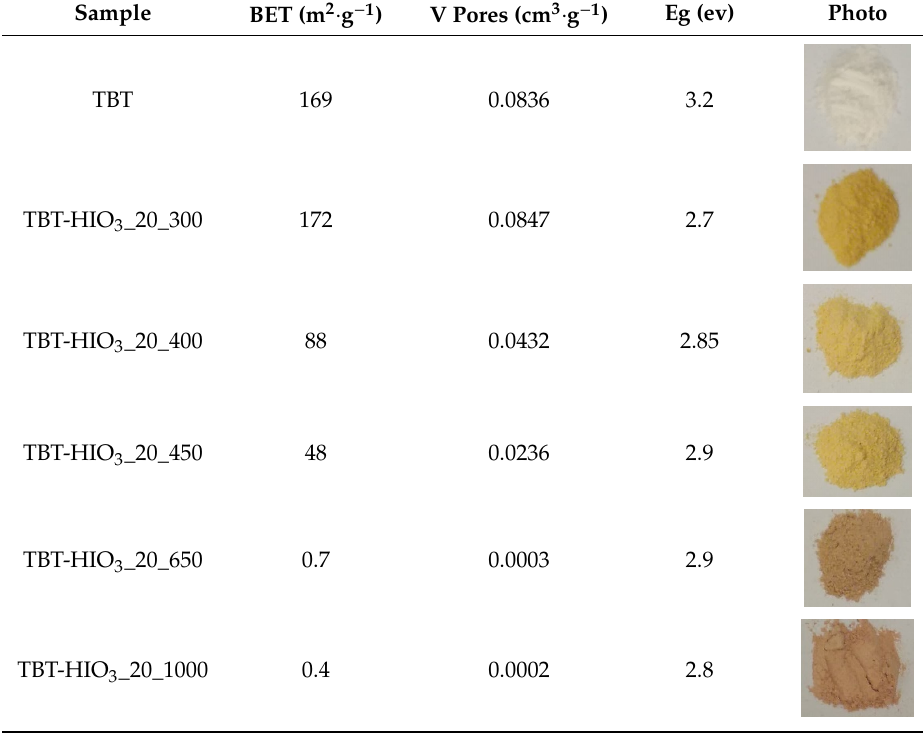
Table 7. Physicochemical characteristic of the obtained defective TiO 2 -HIO 3 _T samples.